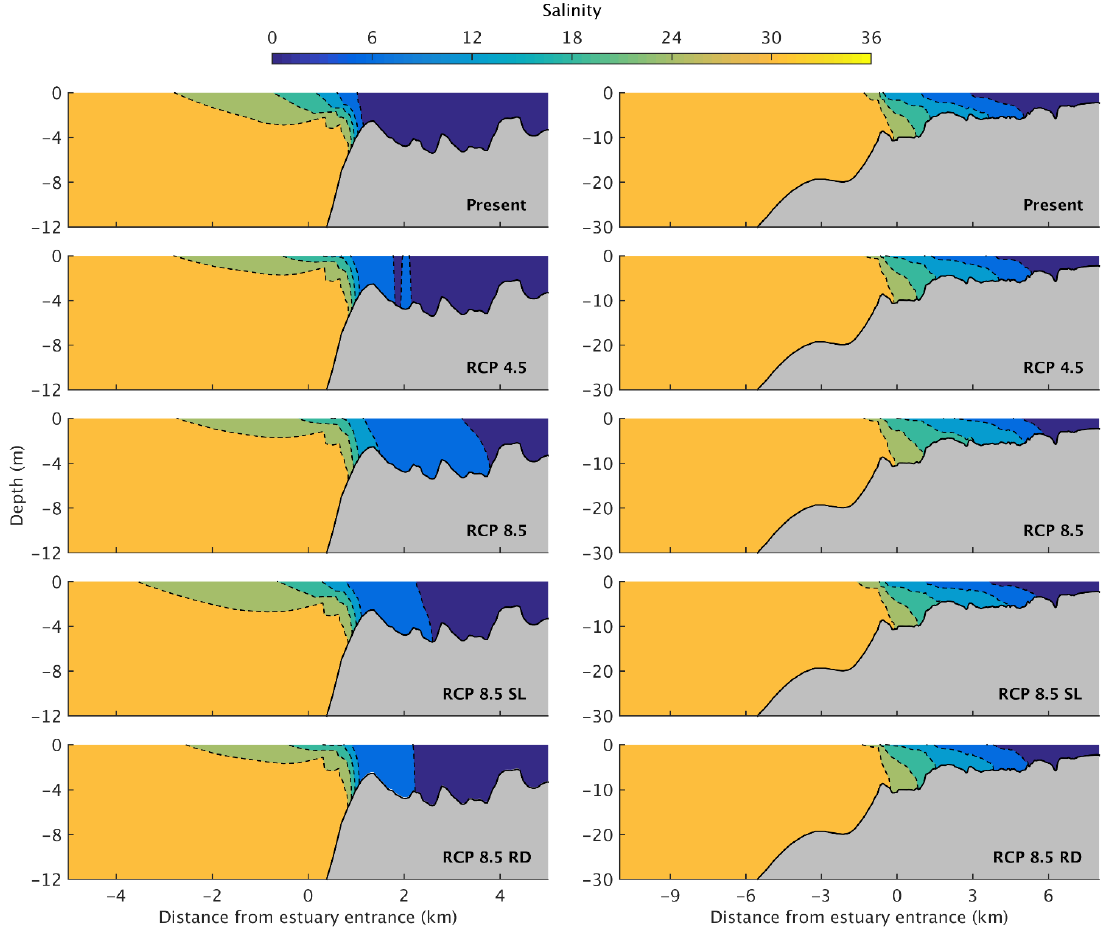
Figure 8. Vertical salinity distribution along the plume/estuary during winter conditions for the Present, RCP 4.5, and RCP 8.5 scenarios. The ( left ) panel represents the Minho estuary and the ( right ) panel the Lima estuary.